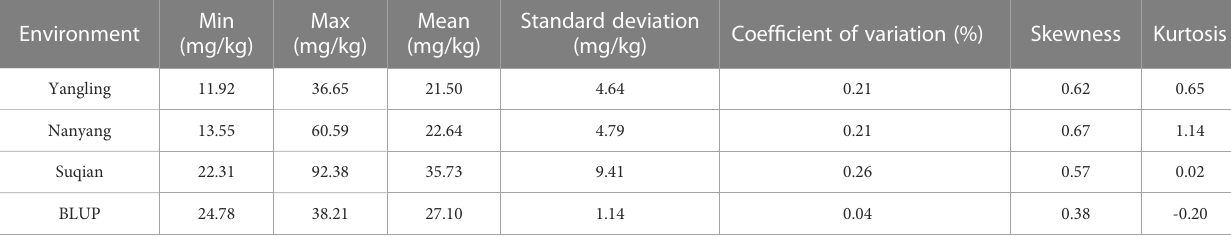
TABLE 1 Phenotypic data of GZnC in three environments and